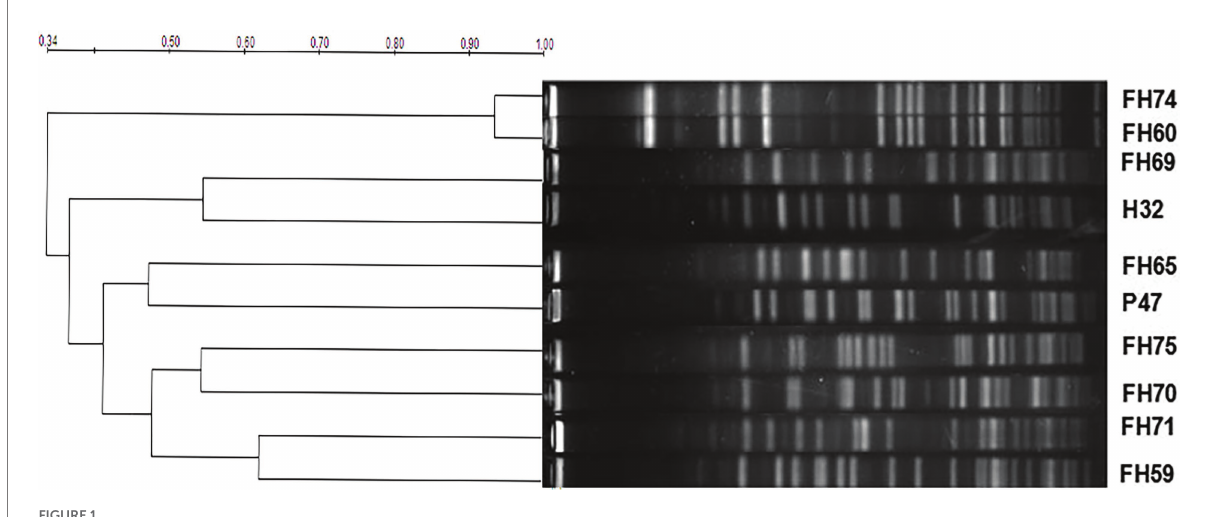
FIGURE 1 PFGE patterns of 10 optrA -positive E. faecium isolates.